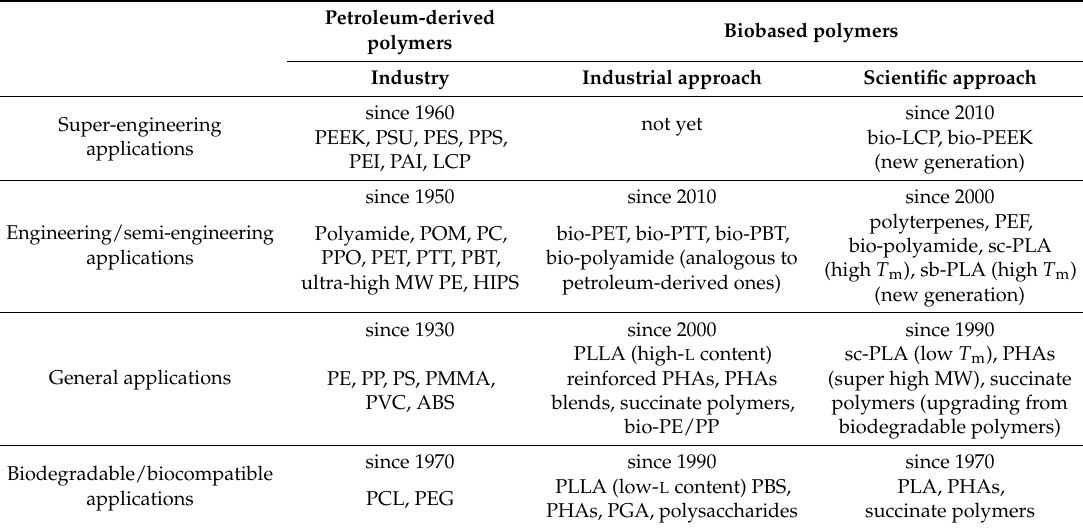
Table 1. Development of biobased polymers and comparison with petroleum-derived